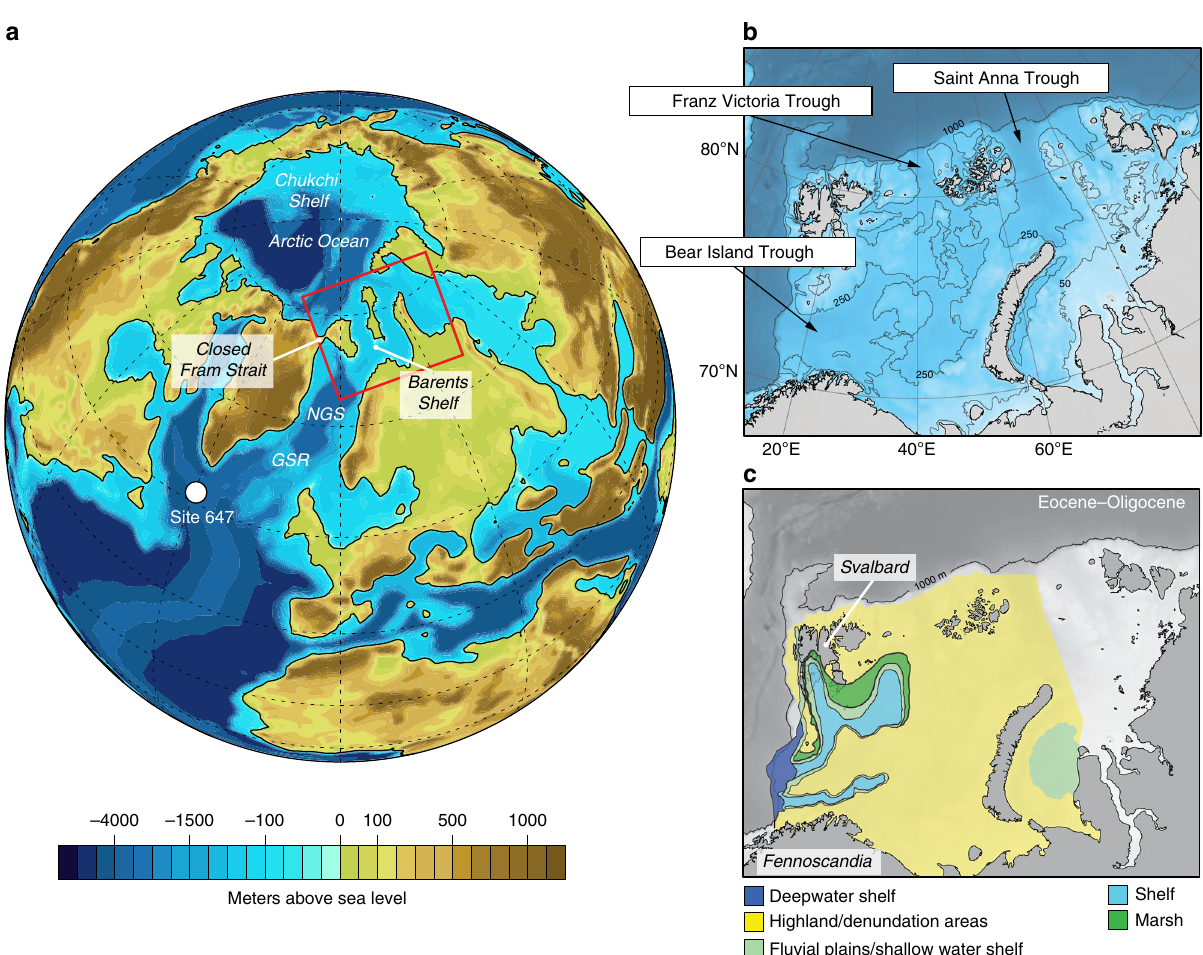
Fig. 1 Contrasting evidence for the existence of seaways across the Barents Shelf near the Eocene – Oligocene transition (EOT). a Palaeogeography for the late Eocene as portrayed by Baatsen et al. 36 . b Modern bathymetry of the Barents shelf. The seaways present across the Barents shelf in the palaeogeography of Baatsen et al. 36 coincide with the deepened glacial troughs that were formed during Quaternary glaciations. c Re-drawn depositional environments on the Barents shelf in the late Eocene, published in Smelror et al. 44 , p. 123. The gradual closure of seaways between Svalbard and Greenland and across the Barents Sea during the Eocene is consistent with far- fi eld geologic evidence 30,39 and recent tectonic reconstructions of the Northwestern and Southwestern margins of the Barents Sea (between Svalbard and mainland Norway) by Lasabuda et al. 45,46 . See Supplementary Fig. 1 for